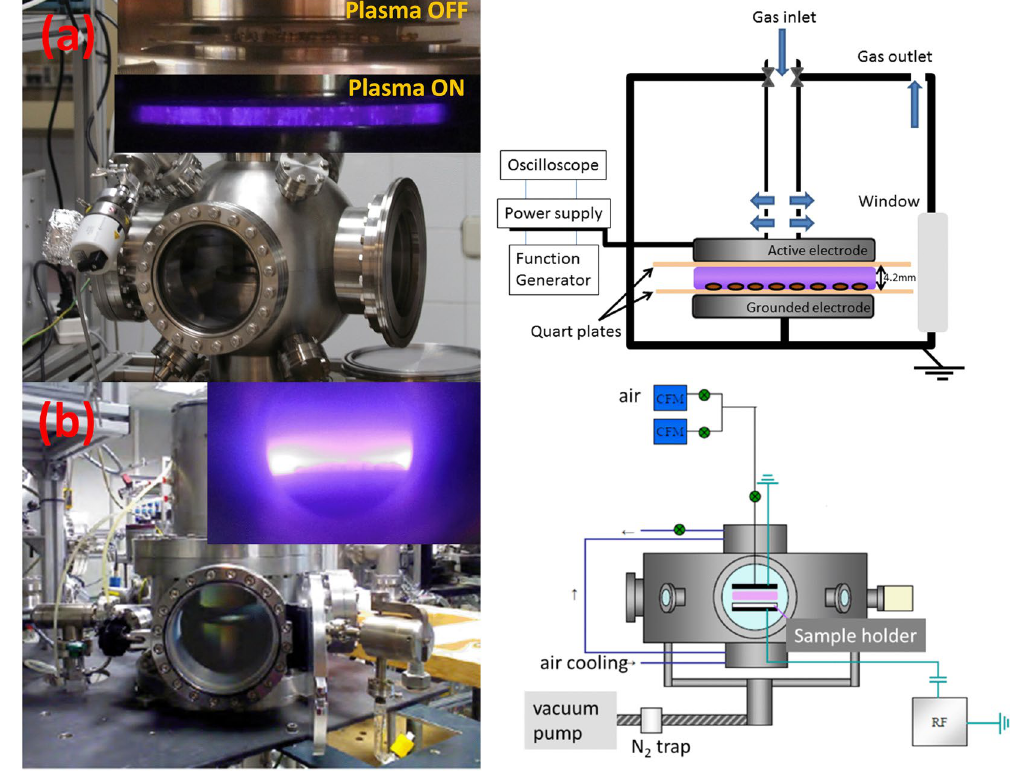
Figure 7. DBD ( a ) and RF ( b ) reactor set-ups and electrical and operational schemes in each